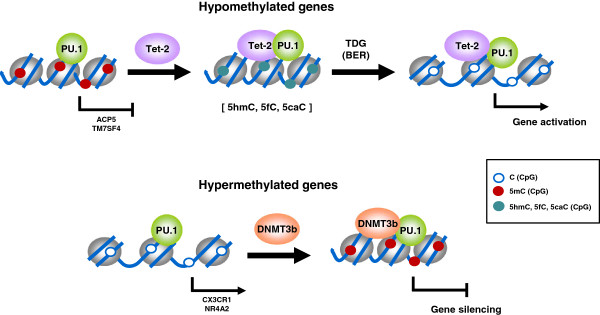
Model showing a simplified diagram proposing the recruitment of TET2 and DNMT3b by PU.1 to its target genes that become hypo- or hypermethylated, respectively, during osteoclastogenesis. Genes that become hypomethylated exchange PU.1-DNMT3b by PU.1-TET2 (although whether pre-existing subpopulations of these associations may exist or, alternatively, post-translational or another mechanisms may mediate exchange of TET2 and DNMT3b; this is not elucidated at present). TDG is likely to mediate conversion of 5hmC/5fmC/5caC to demethylated cytosine. Hypermethylated genes experience an increase in the binding of DNMT3b as differentiation to OCs is triggered.